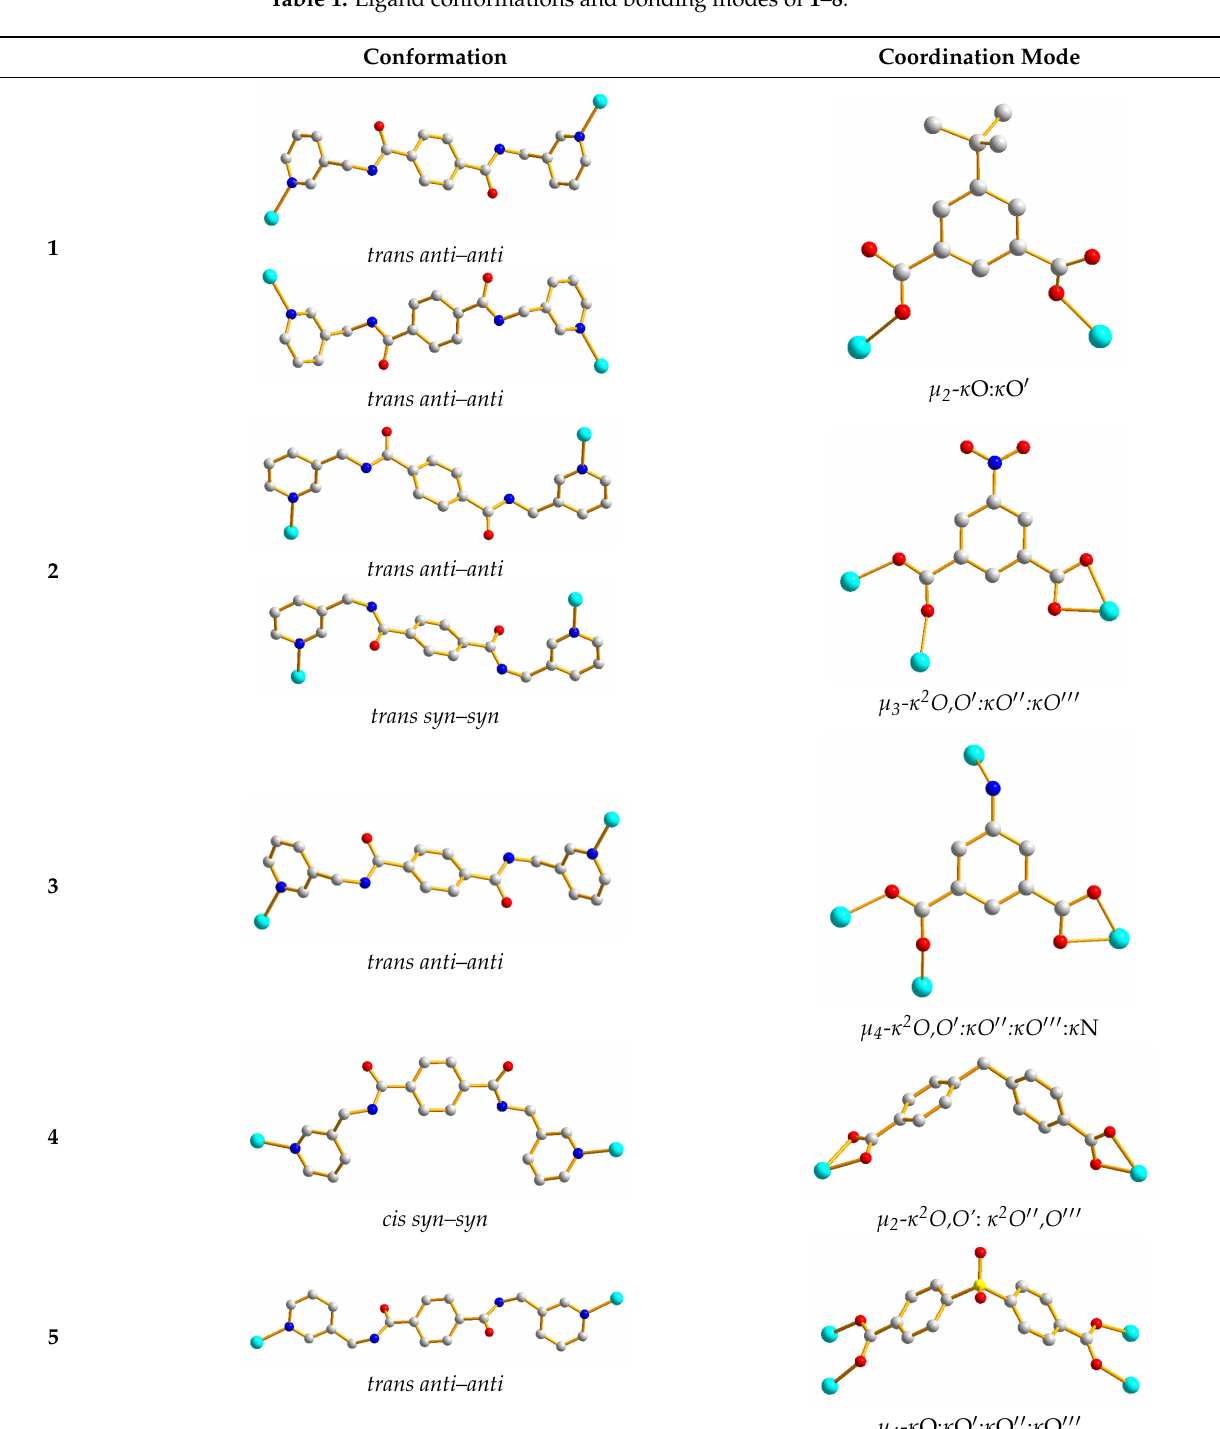
Table 1. Ligand conformations and bonding modes of 1 – 8